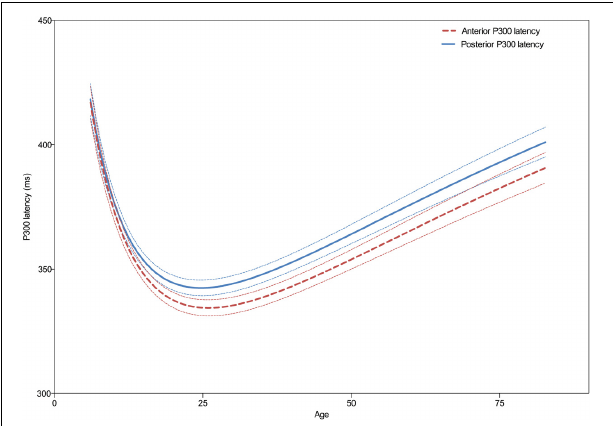
FIGURE 3 | Developmental trajectories of the frontal (Fz) and parietal (Pz) P300 latency across the lifespan. Dashed lines indicate the 95% confidence interval. Note the similarity in developmental trajectories, with only an apparent overall difference in frontal and parietal latencies but not in its progression across the lifespan.